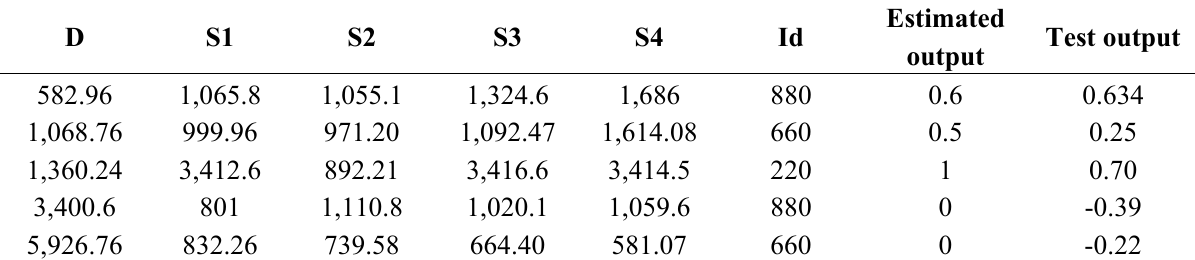
Table 6. Outputs of the Neuro-Fuzzy system for real data and the simulated data in the case, where a corner is being detected. S1, S2, S3, S4, Id and D values are given in